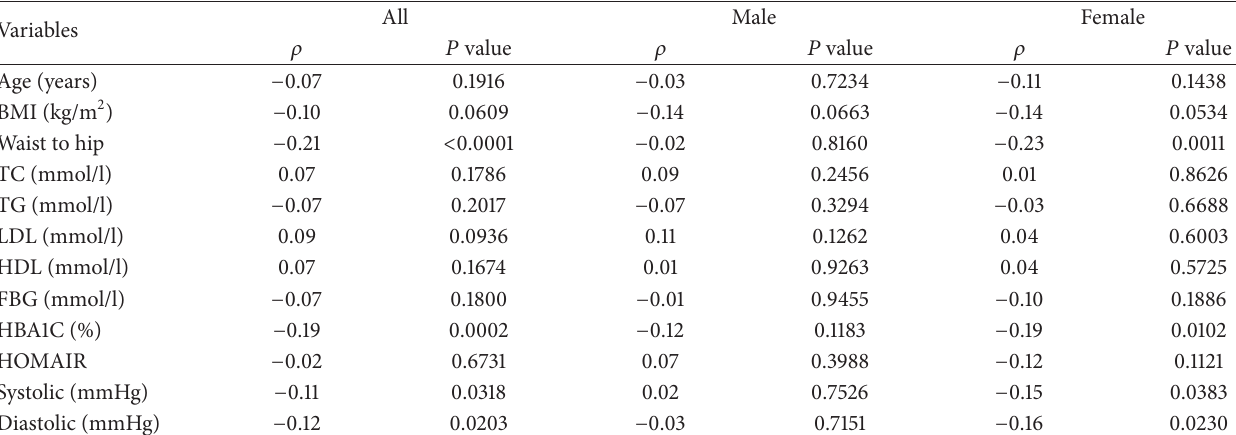
Table 2: Spearman correlation of ghrelin marker with cardiometabolic risk